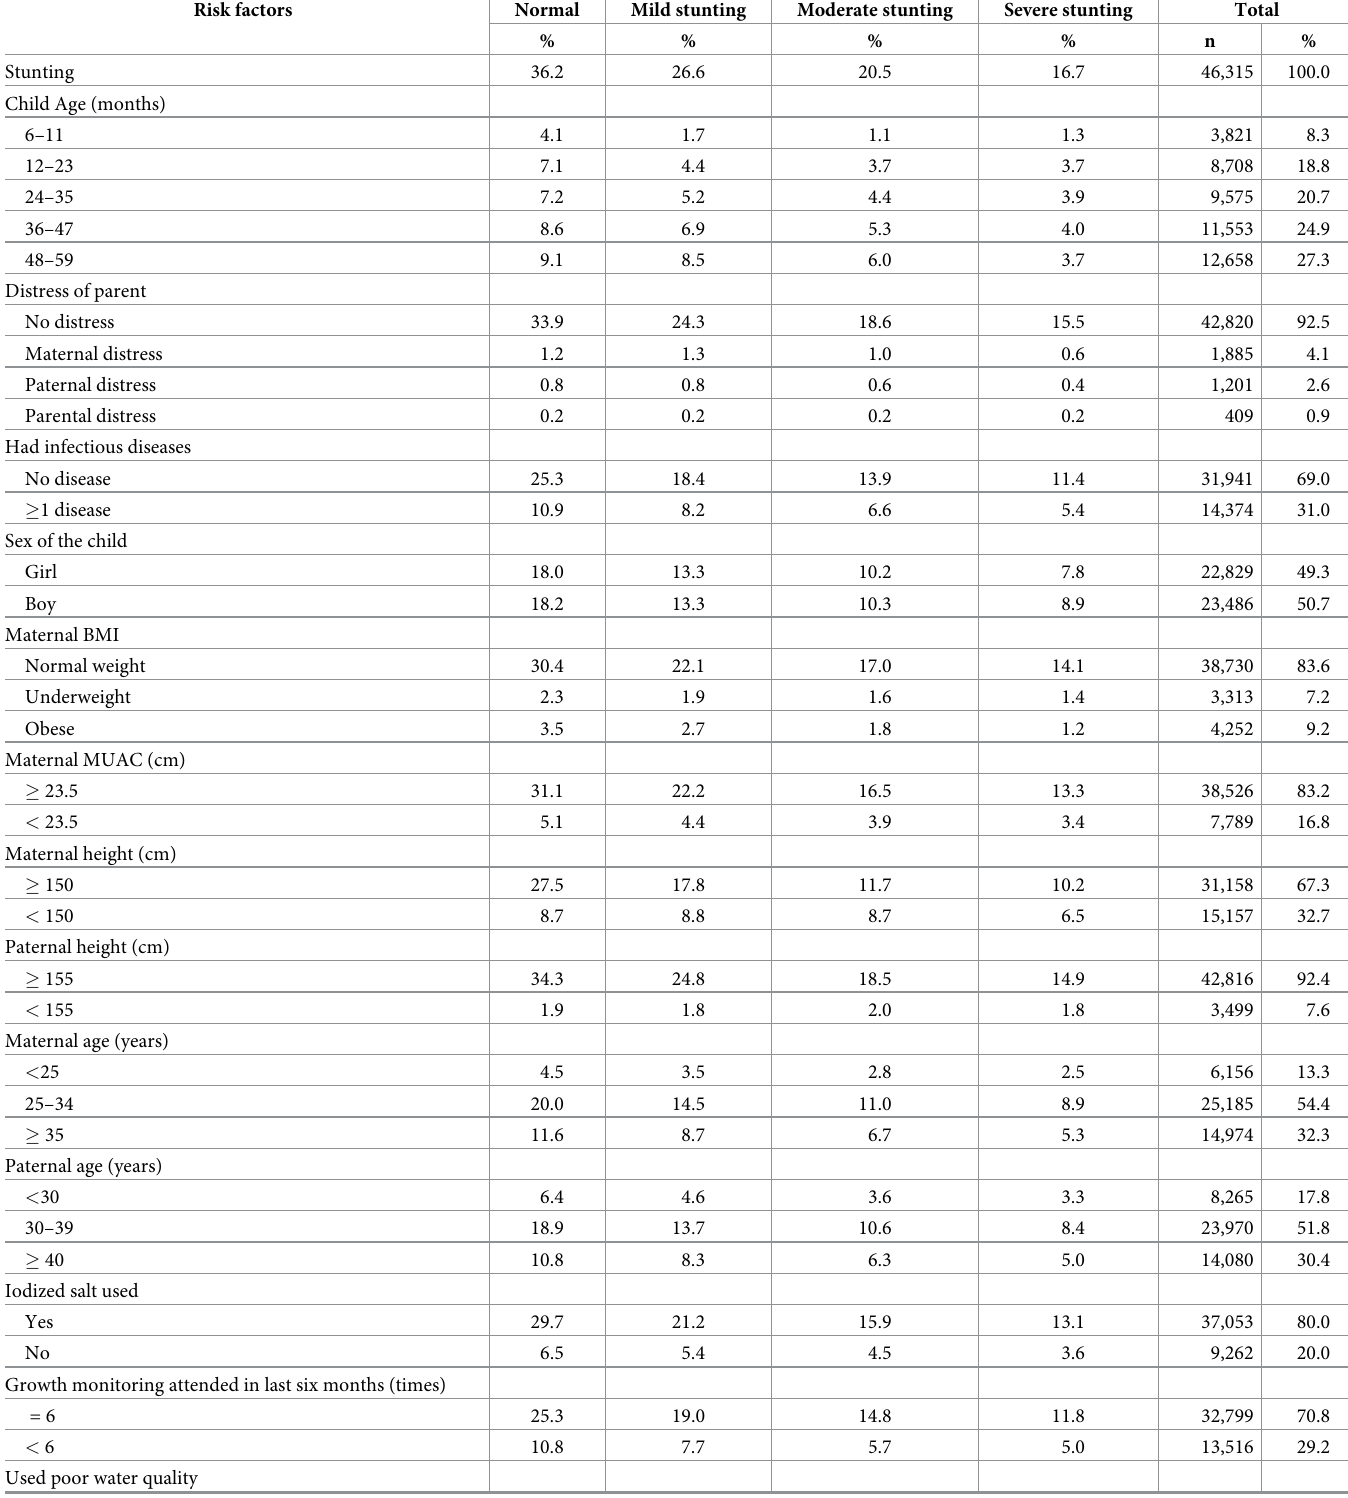
Table 1. Characteristics of children and household according to stunting